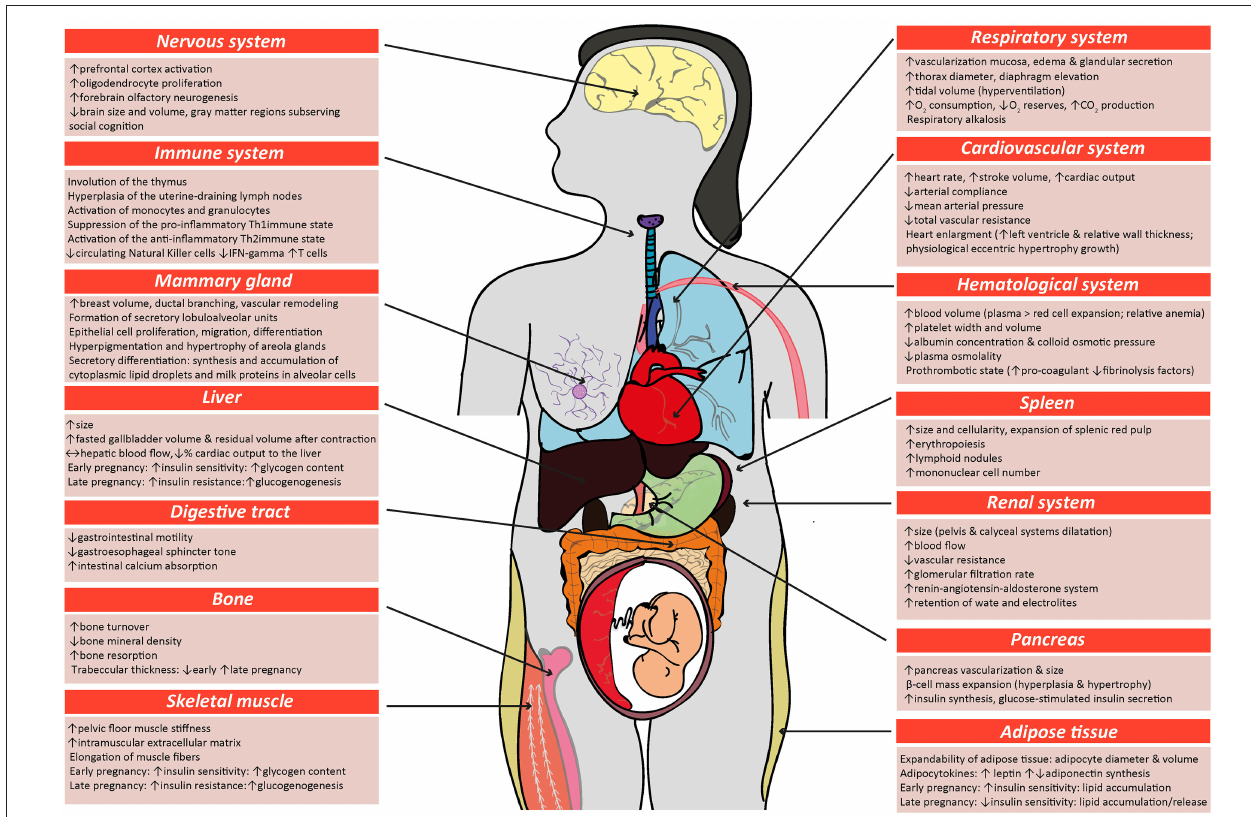
FIGURE 1 | Schematic diagram highlighting the main physiological modifications in the maternal physiology in response to pregnancy. Many of the changes described in the figure for women during pregnancy also occur in other species, including mice. Respiratory system ( Macrae and Palavradji, 1967; Weinberger et